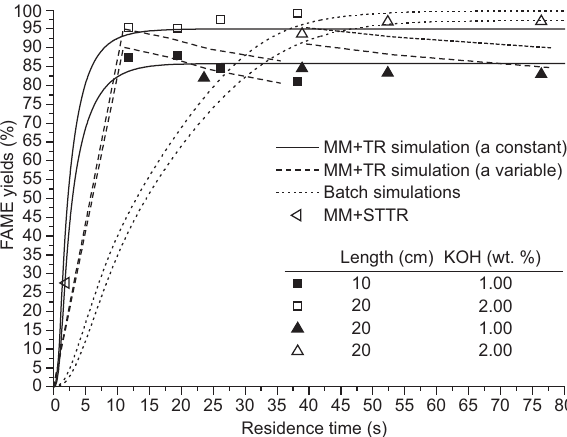
Figure 2 Obtained agreements for the experimental runs reported in Table 1. Symbols represent the experimental points, whereas lines represent the simulations. In the same plot, the simulation obtained by assuming the kinetic parameters valid for the stirred batch reactor is also reported. MM + STTR stays for Micro mixer + Small Tefl on Tubular Reactor (10 cm length, 1/16 ″ of external diameter).